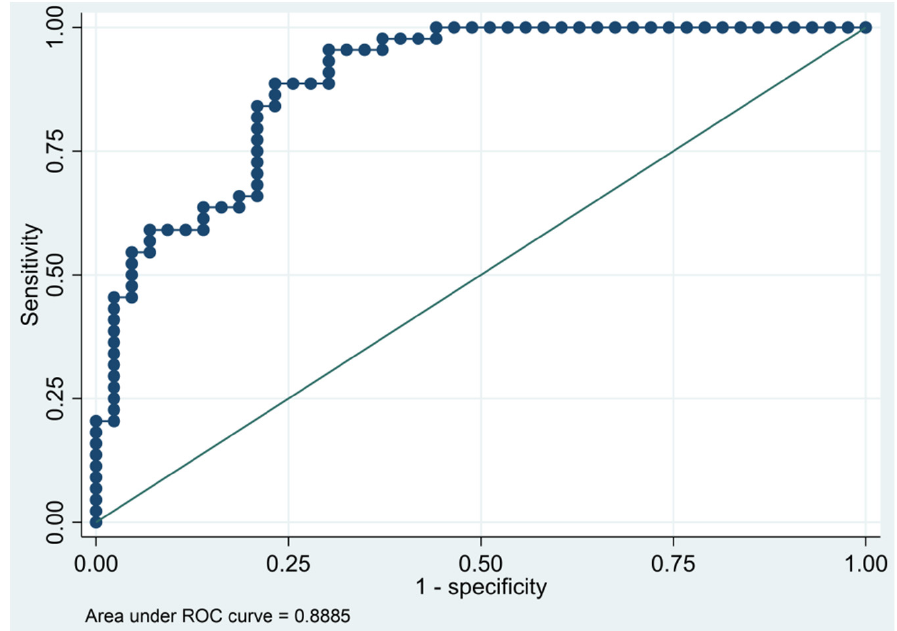
Figure 4. Receiver operating characteristics curve of the final multivariate logistic regression model based on cytokines from the oncology panel.